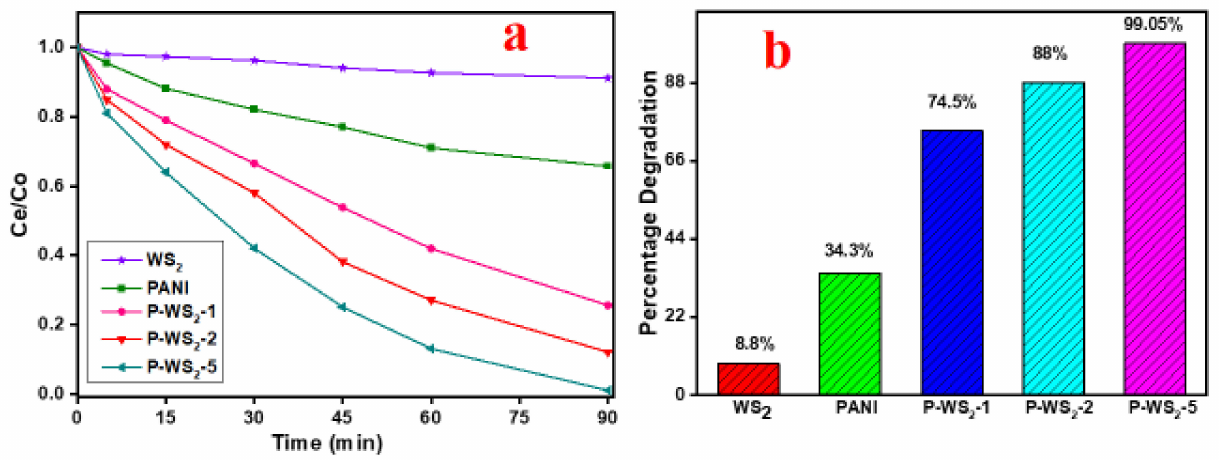
Figure 9. ( a ) Adsorption–desorption equilibrium rate of MB under dark conditions versus time in the presence of various photocatalysts and ( b ) UV-vis absorption spectra of MB aqueous solution at 75-min dark adsorption–desorption